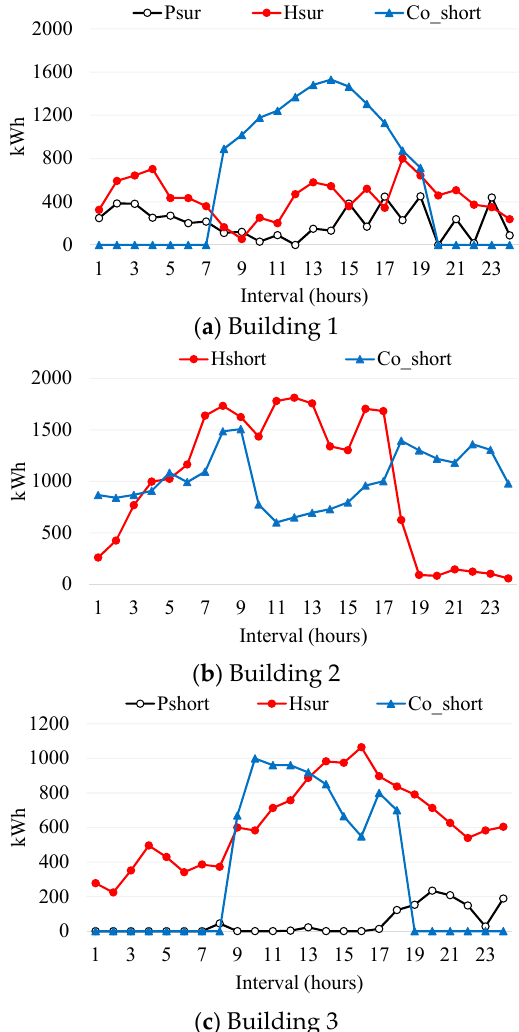
Figure 7. Information of the surplus/shortage energies in each building during a weekday.